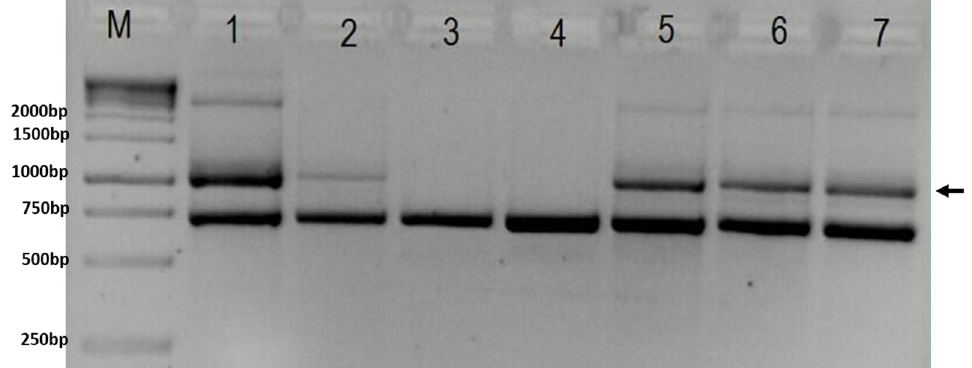
Figure 2. Gel-electrophoresis showing results of PCR test for deletion in the IKBKG gene (M—1 kB ladder; 1 and 2—positive controls; 3—negative control; 4—brother; 5—proband; 6—sister; 7—mother). Arrow indicates 1045 bp band present in case of deletion. The lower band represents 733 bp internal control. In column M is GeneRuler 1 kb DNA ladder (Thermo Scientific, USA, cat. No SM0311), with marked band size on the right.